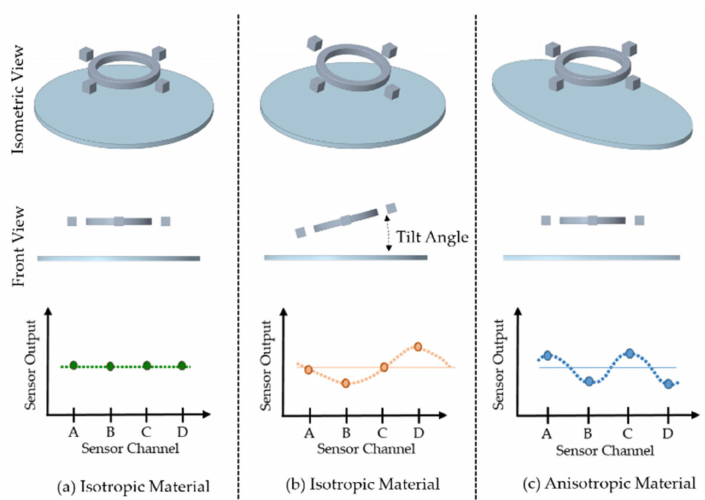
Figure 2. Representation of the four sensor outputs for three different scenarios: ( a ) Isotropic material aligned parallel to the sensor; ( b ) Isotropic material aligned tilted to the sensor; ( c ) Anisotropic material aligned parallel to the